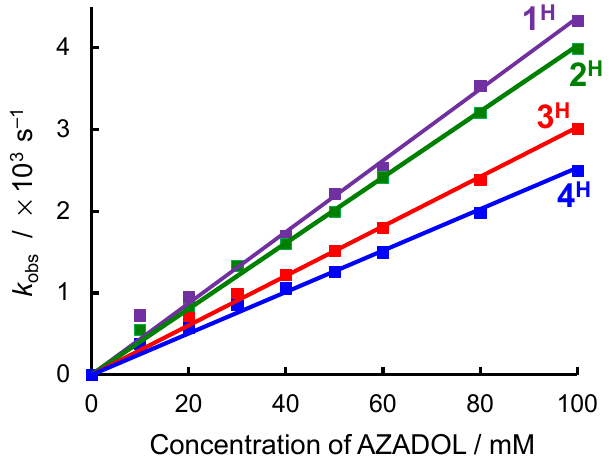
Figure 6. Plots of the concentration of AZADOL versus k obs for 1 H – 4 H .